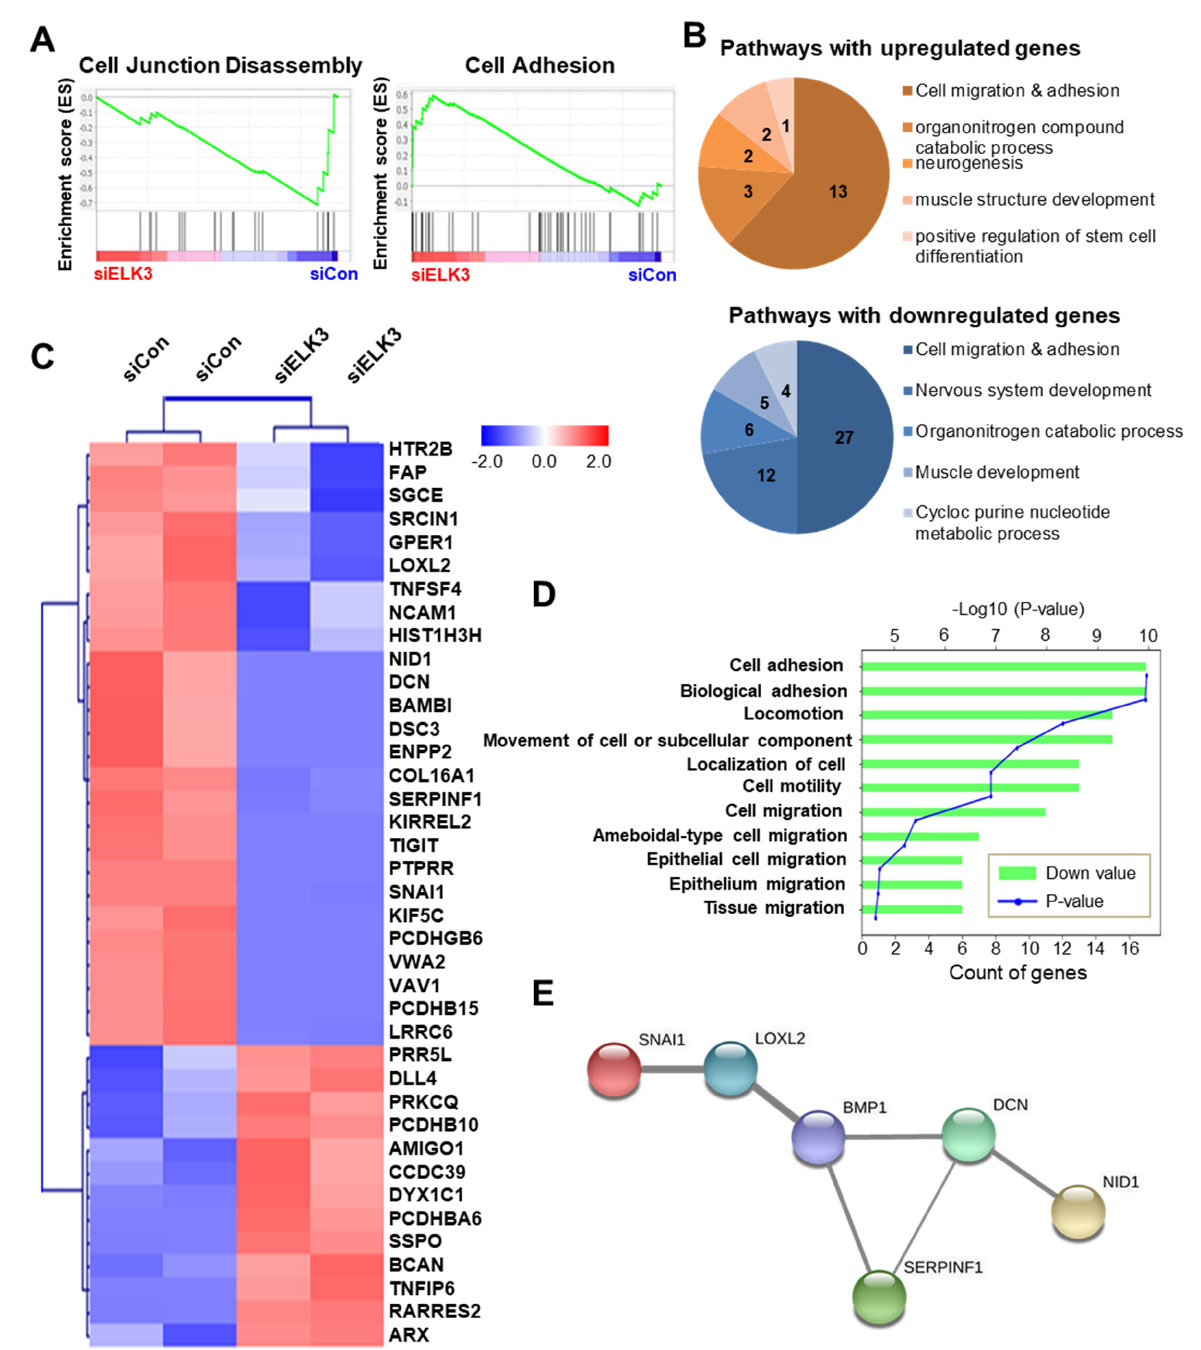
Figure 4. ELK3 controls extracellular matrix (ECM) remodeling-related genes to control cell migration. ( A ) Gene set enrichment analysis of RNA sequencing data from SNU638 cells transfected with siCon or si ELK3 . Cell adhesion-related genes were positively enriched and cell junction disassembly-related genes were negatively enriched in SNU638 cells transfected with si ELK3 . ( B ) Pie graphs showing biological pathways in ELK3 -depleted SNU638 cells. Numbers indicate the number of genes in each biological pathway. ( C ) Heatmap analysis of genes associated with cell migration and cell adhesion. ( D ) Bar graph showing the Database for Annotation, Visualization, and Integrated Discovery (DAVID) annotation of genes involved in cell migration and cell adhesion. ( E ) Map data of Search Tool for the Retrieval of Interacting Genes analysis (STRING). The thickness of the lines represents the confidence of the